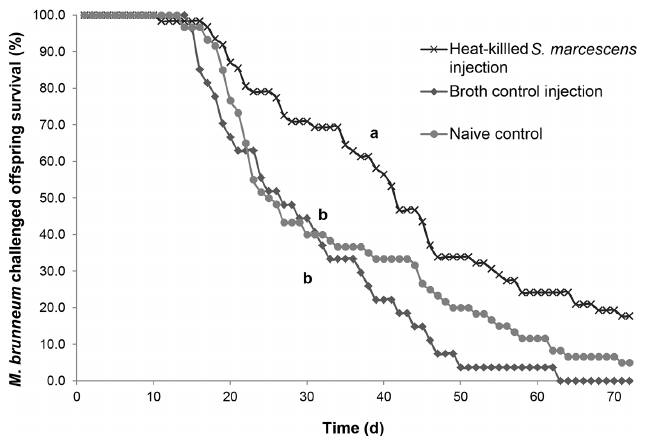
Fig 1. Survival curves for offspring of the S . marcescens treatment. Percentages of male and female (merged) offspring treated with M . brunneum surviving over time whose mothers were challenged with either S . marcescens or a control treatment (naive control or broth control). Different letters signify significant differences in survival curves between treatments (risk ratios, p (cid:1) 0.0167).